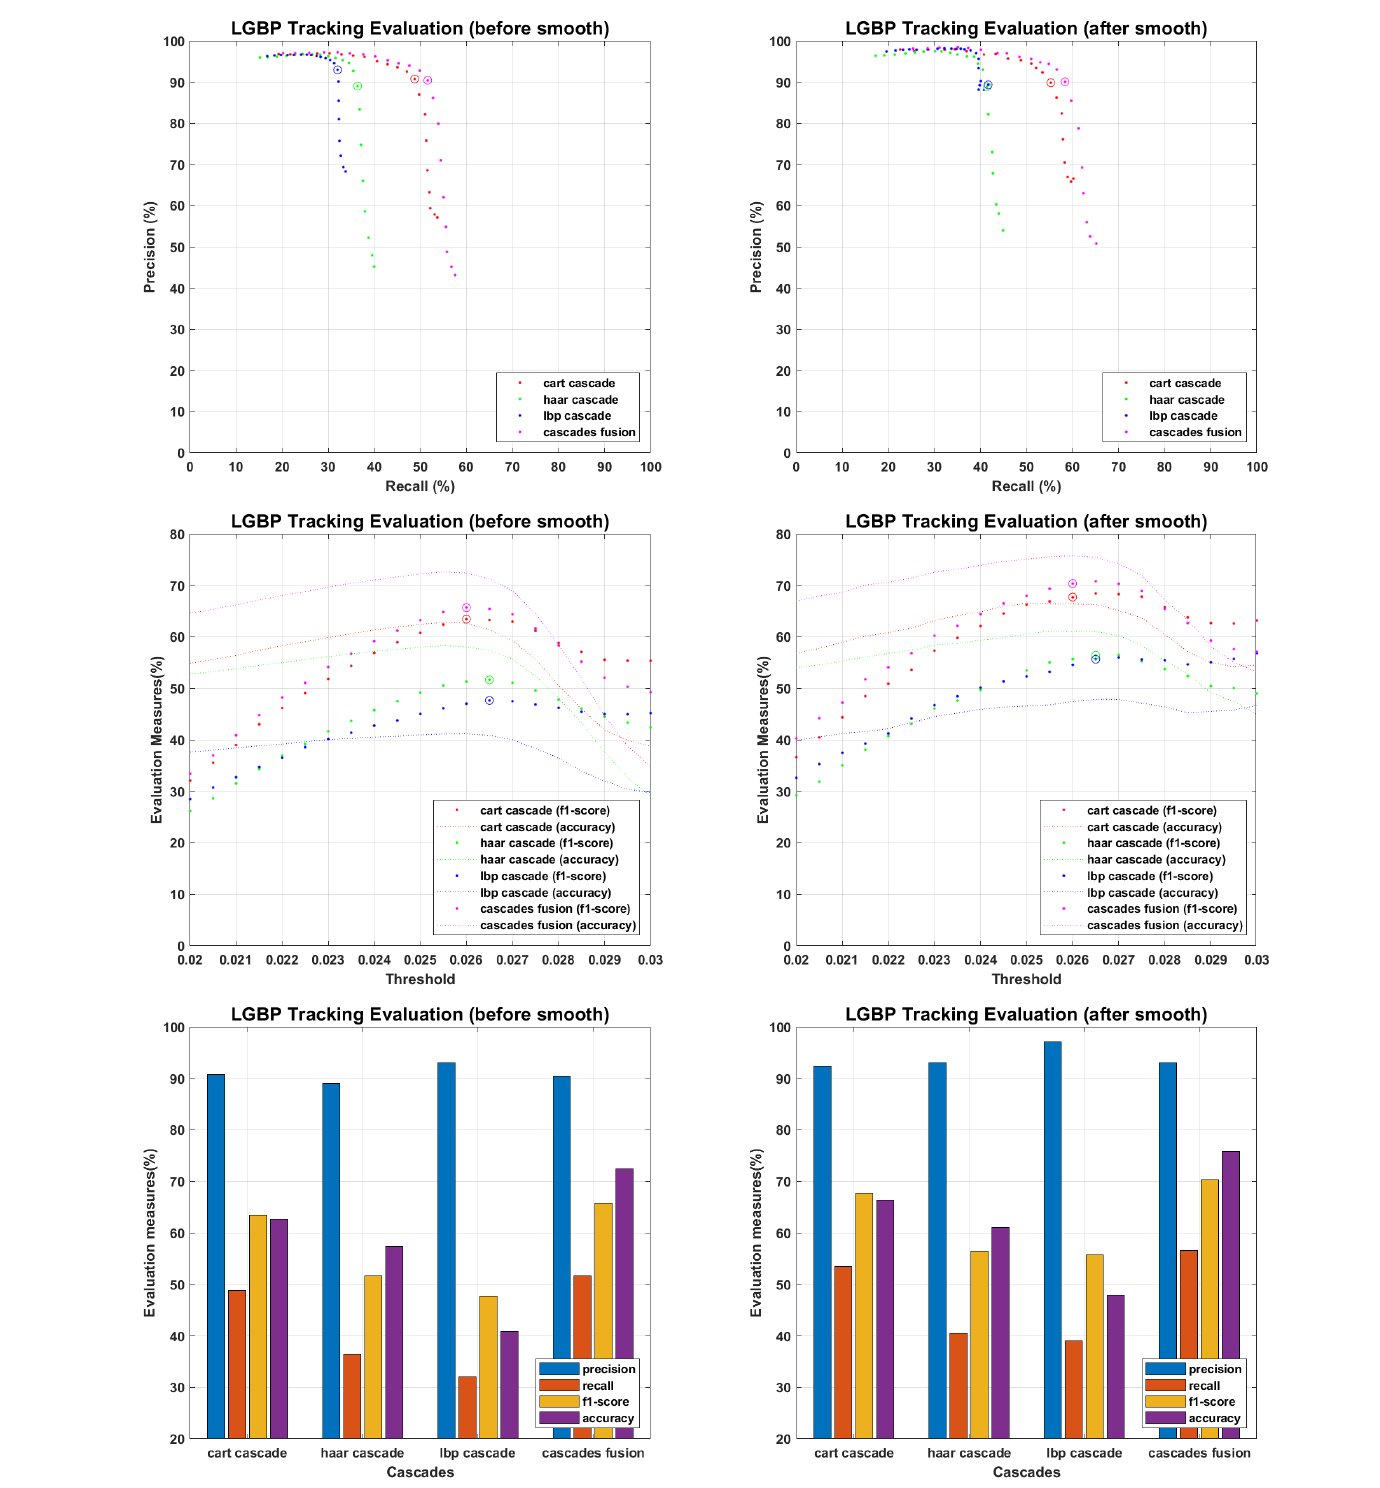
Figure 18. Tracking Evaluation for